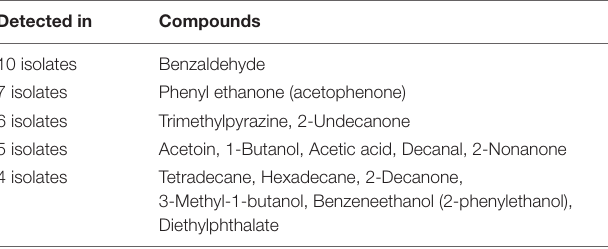
TABLE 3 | Non-isolate-specific volatile secondary metabolites from B. subtilis.